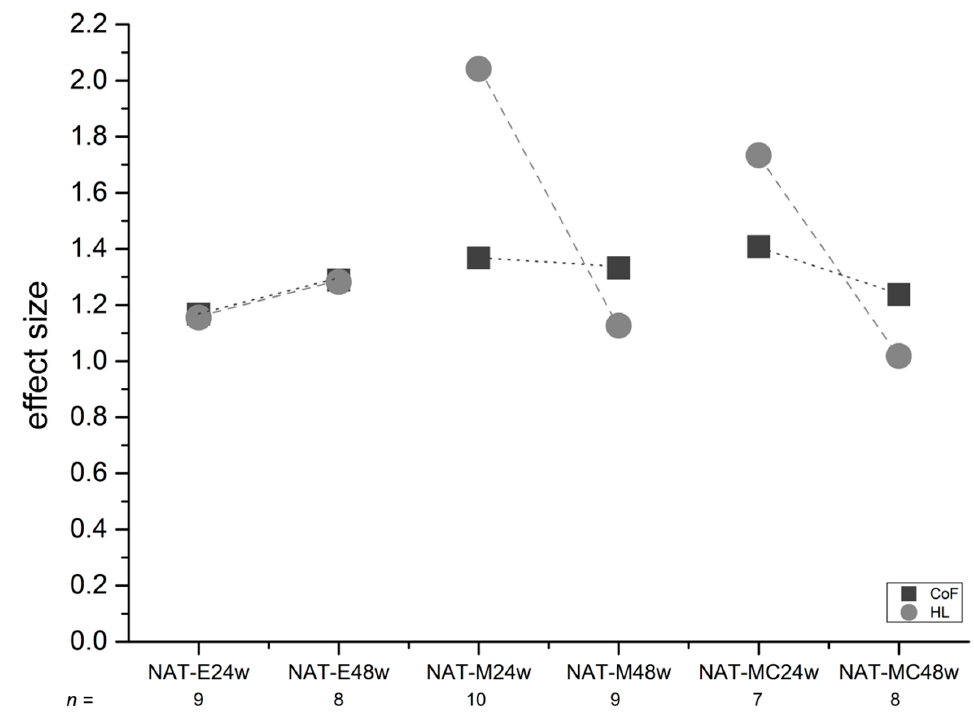
Figure 4. The effect sizes (ESs) of the CoF and HL were calculated for the comparisons between the NAT group and each of the operated groups.